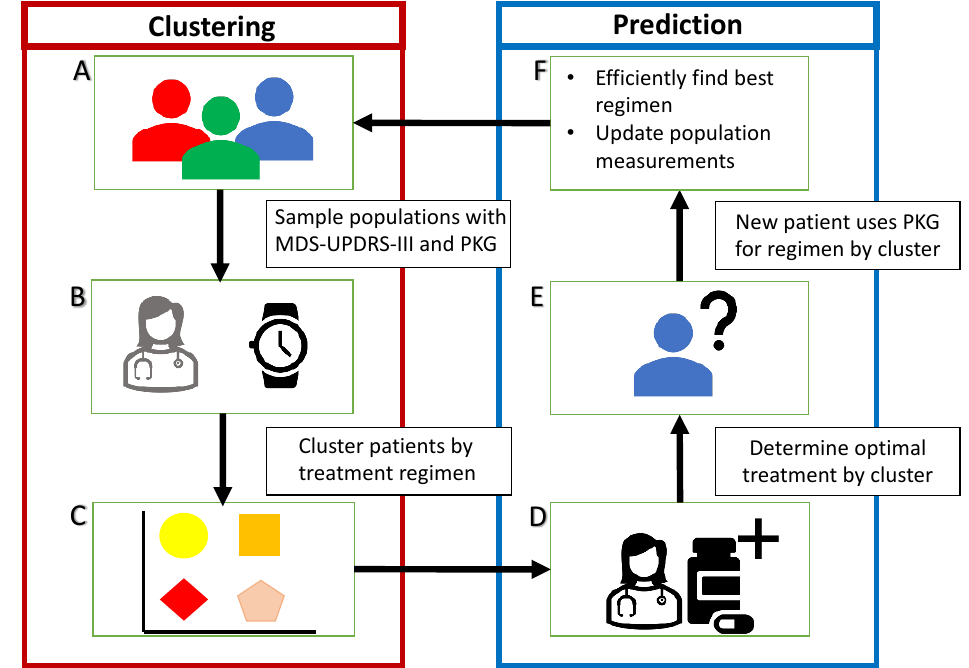
Figure 2. The study design is divided into two parts as labeled by the blocks “Clustering” and “Pre- diction”. In the clustering block, ( A ) we begin with a diverse cohort of PD patients; ( B ) each patient is assessed by MDS-UPDRS-III scores and PKG summary dyskinesia and bradykinesia scores; the physician icon is greyed out as in the future for some remote contexts this may be accomplished using only the PKG time-series data, but we currently collect both for validation purposes; ( C ) we identify similar medication regimen clusters through k-means clustering. These clusters are used in the prediction block; ( D ) we optimize medication regimens and perform statistical analysis on demo- graphic similarities for each group—to create a decision support tool to provide enhanced initial regimen estimates; ( E ) machine learning methods, specifically random forest, are applied to predict an unknown patient’s optimized regimen cluster based on physician assessment and/or wearable sensor measurements depending on the context; ( F ) the new patient’s data will be incorporated to improve the accuracy of the decision support tool.